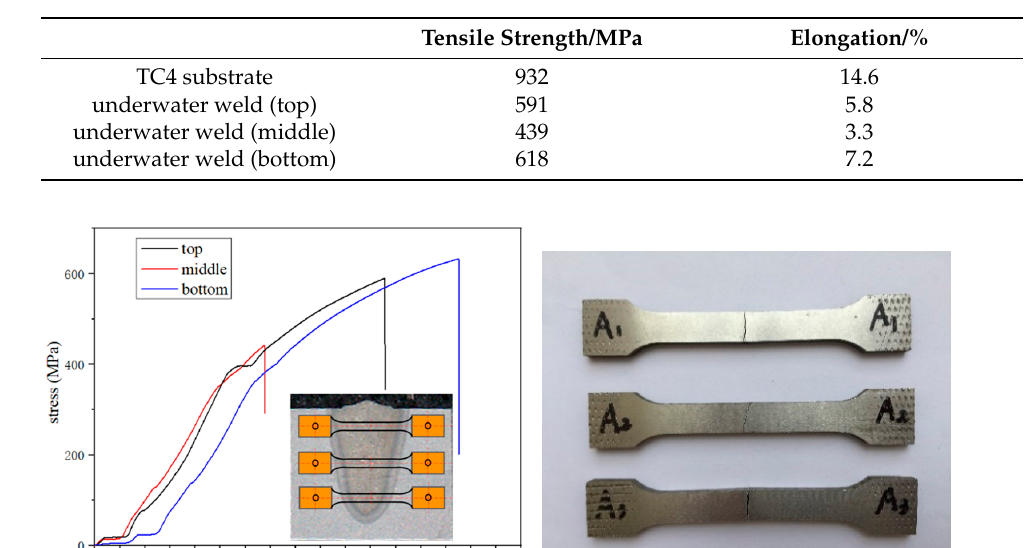
Table 2. Tensile results of different tensile specimens.